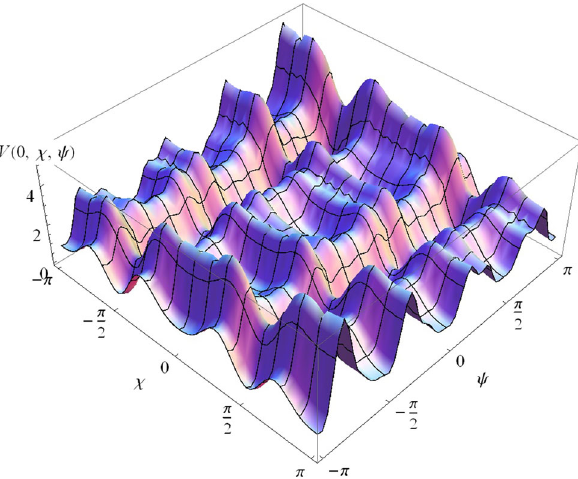
Fig. 13 Plotoftheprojectionofthepotential V ( 0 ,χ,ψ) forthevalues α = 1, β = 1, γ = 2, a